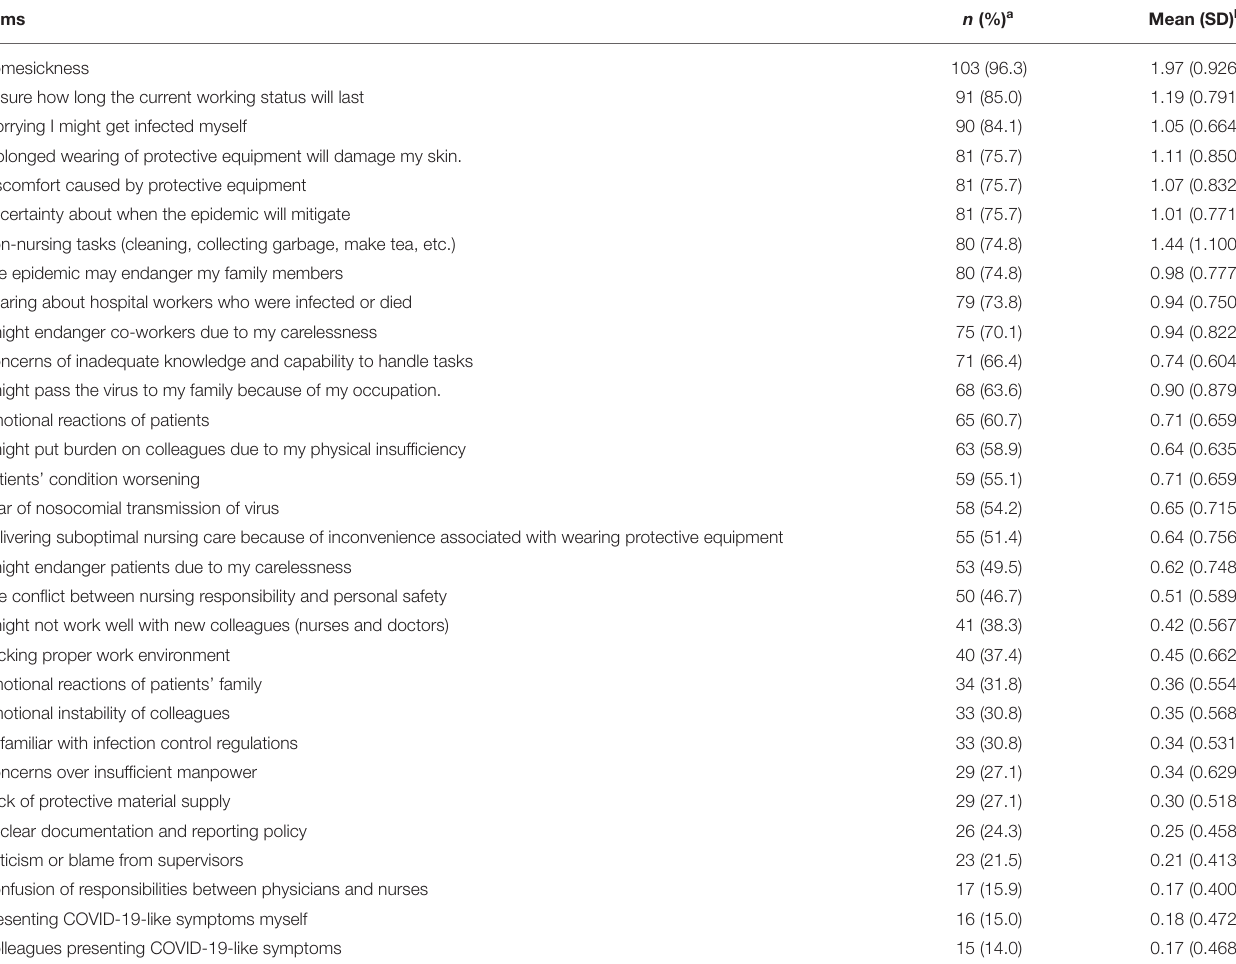
TABLE 2 | Stressors and stress severity ( n =